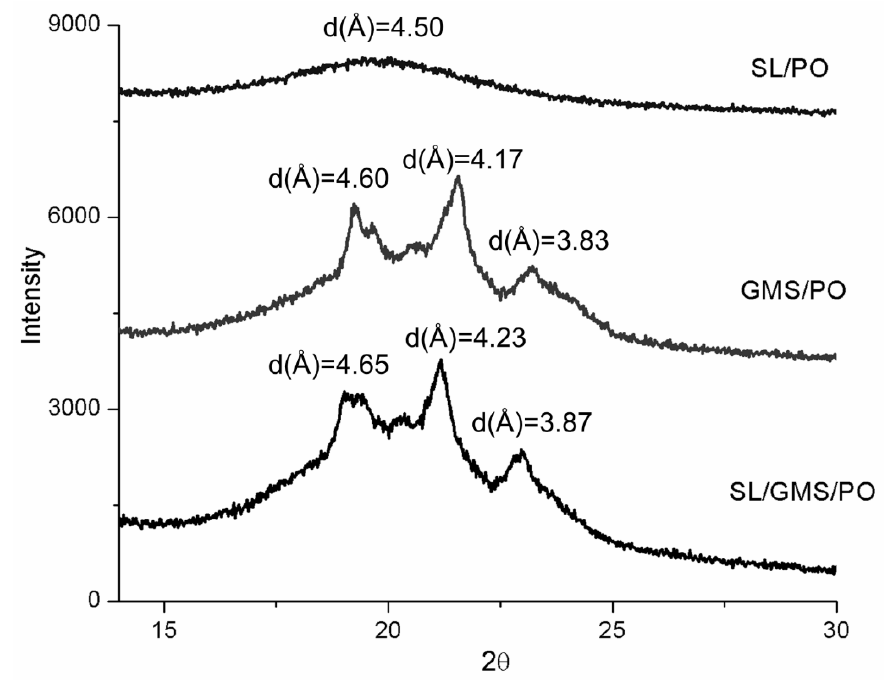
Figure 4. The XRD graphs of SL/PO, GMS/PO, and SL/GMS/PO organogels.